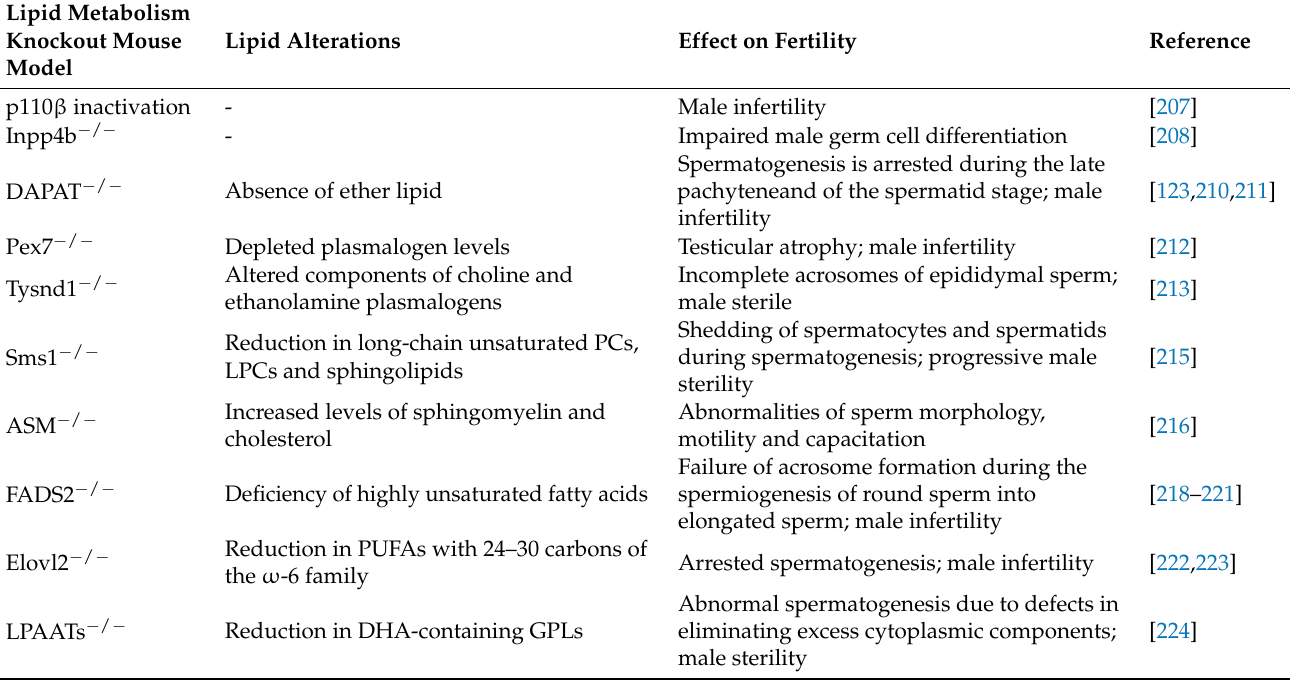
Table 2. Effects of lipid metabolism-related knockout in mice on